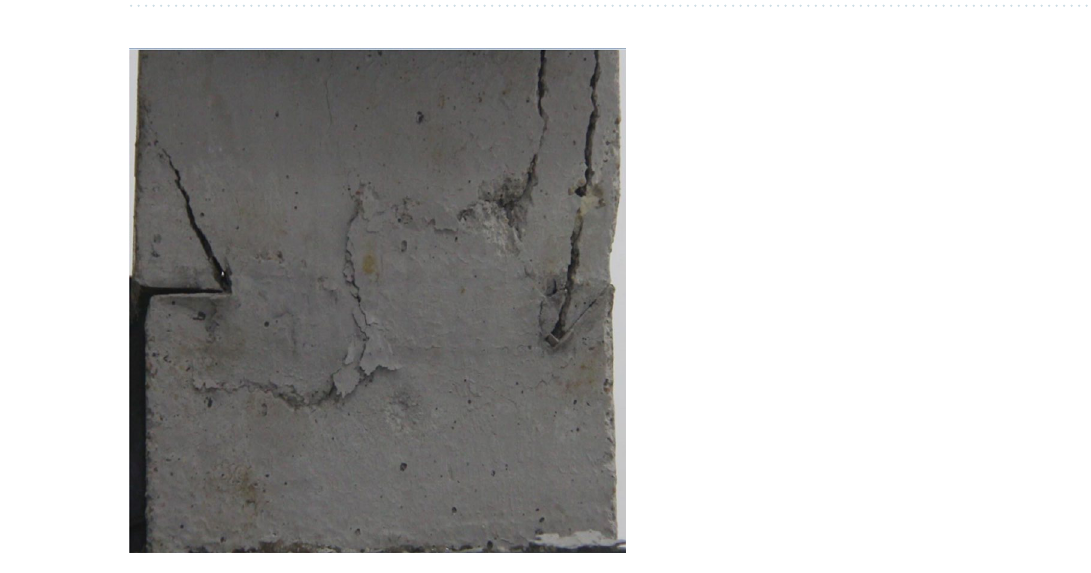
Figure 25. Photograph of a specimen showing anti-tensile wing crack Propagating and another anti-tensile wing crack appearing.